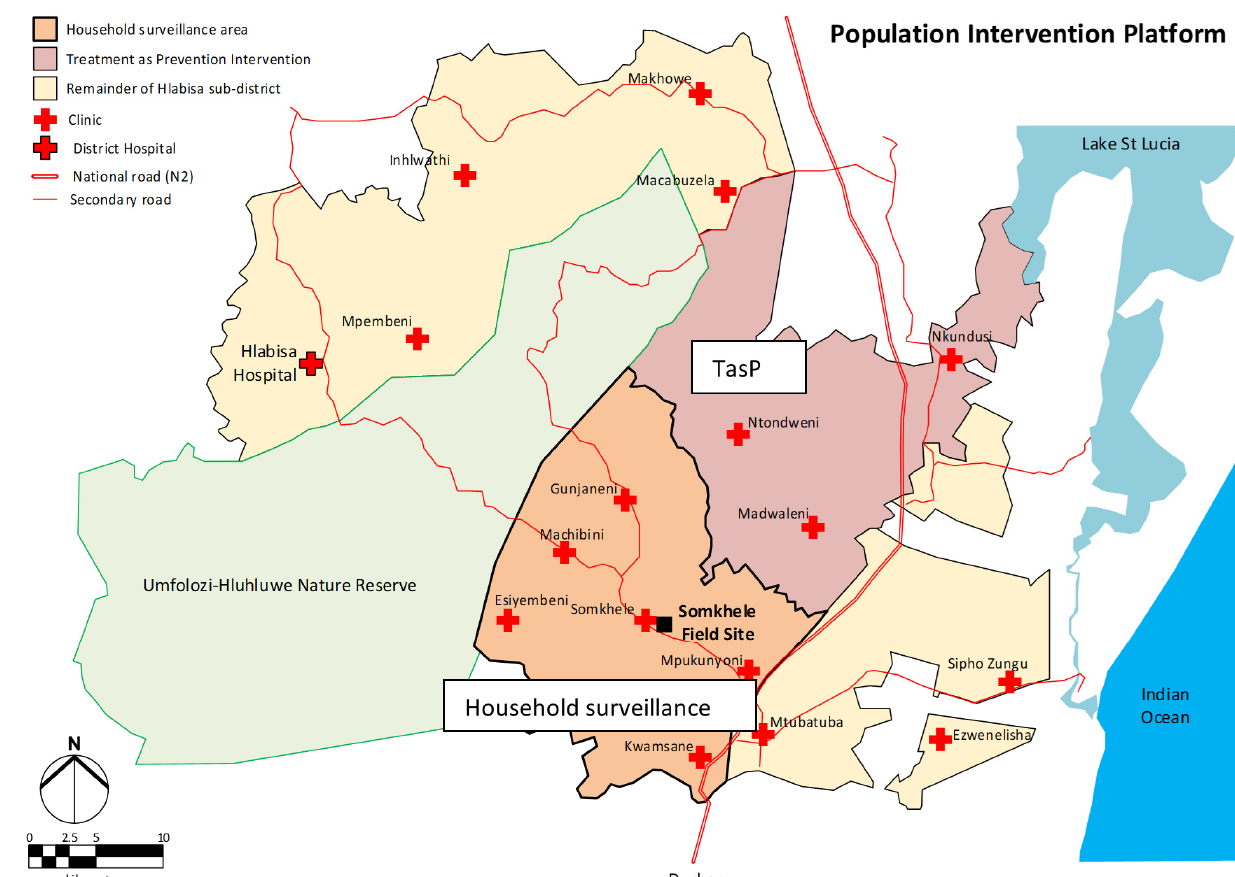
Figure 1. The Hlabisa sub-district showing the Africa Health Research Institute Population Interven- tion Platform comprising the areas denoted as TasP (Treatment as Prevention) and Household